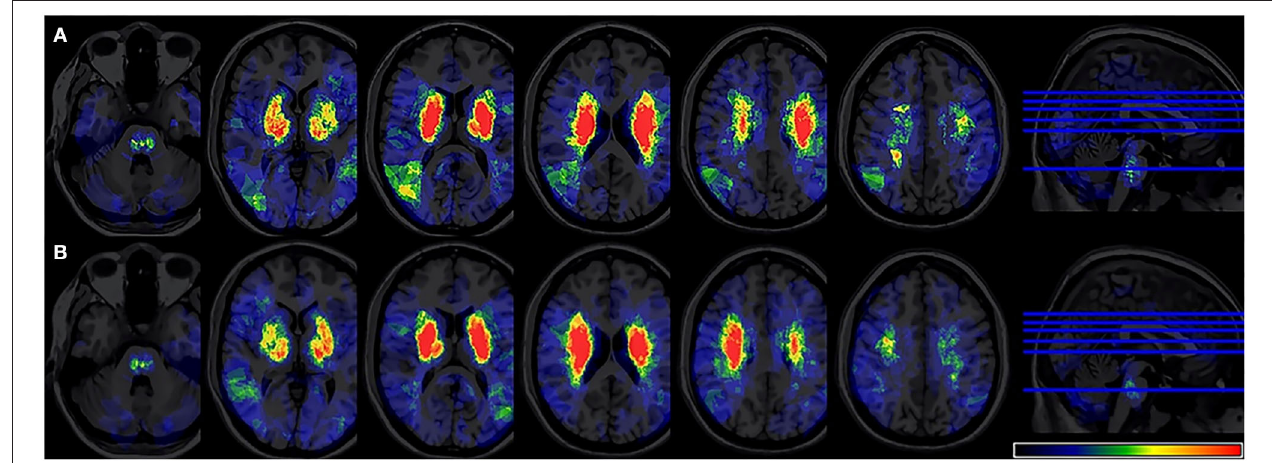
FIGURE 2 | Lesion probability map. (A) A total of 361 patients were included in the acute phase VLSM analysis. (B) A total of 324 patients included 6-month follow-up VLSM analysis. The color represents the frequency of overlap. VLSM, voxel-based lesion-symptom mapping.